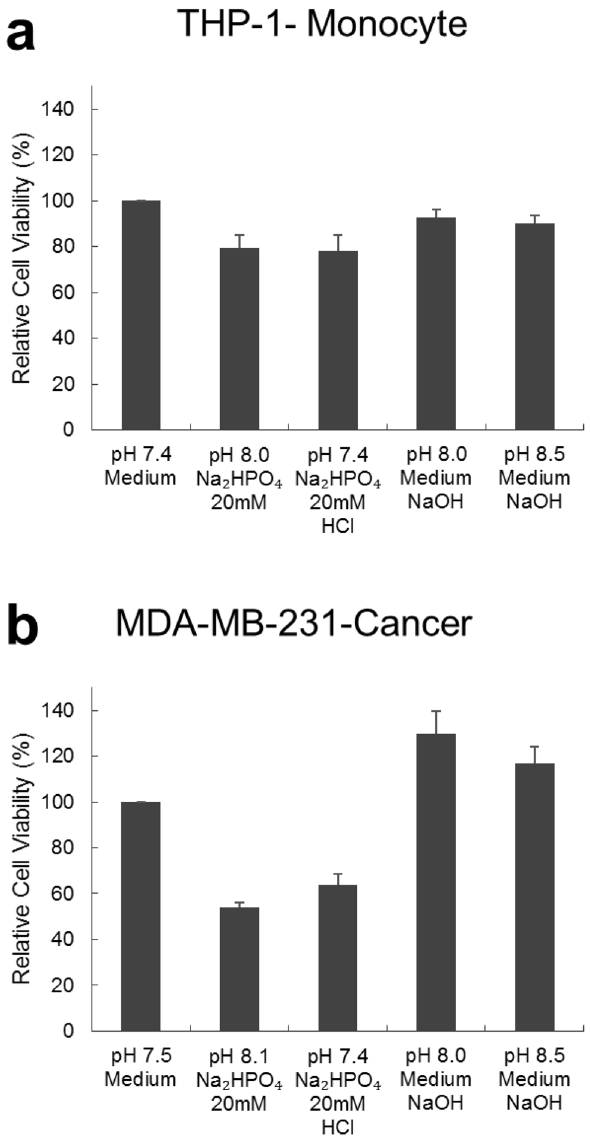
Figure 8. Viability of ( a ) THP-1, human monocyte cell line, and ( b ) MDA-MB-231, breast cancer cell line, after adding Sodium Phosphate Dibasic (Na 2 HPO 4 ) and adjusting pH to physiological one, evaluated after 48 h of incubation with the compound. Adjusting the pH to physiological range (7.4–7.5) after adding Na 2 HPO 4 increased the viability of cells by 18% (approaching significance). Media only and media with NaOH are controls. Experiment was done in triplicate and the sample number for each replicate is